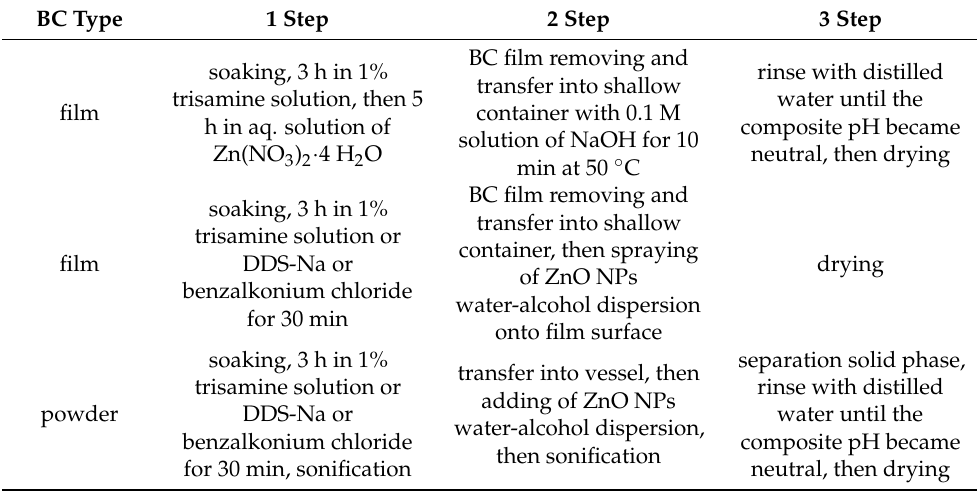
Table 1. Preparation procedure of BC (bacterial cellulose)-ZnO (nanoparticles) NPs composites. BC